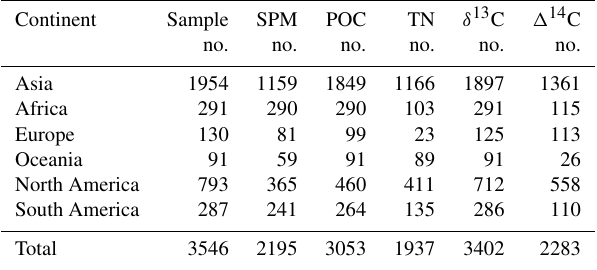
Table 1. Riverine SPM data availability for each continent. Continent